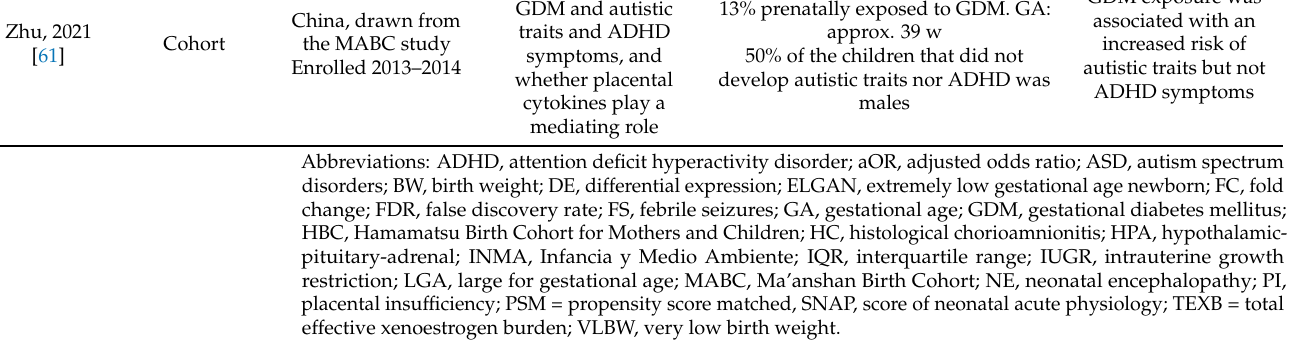
Table 2. Results from the risk of bias assessments of the included studies using